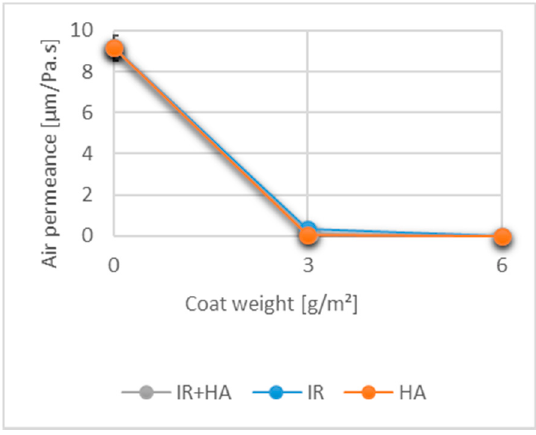
Figure 6. Air permeance for uncoated paper and coated substrates with one and two layers of chitosan. ( n = 15).